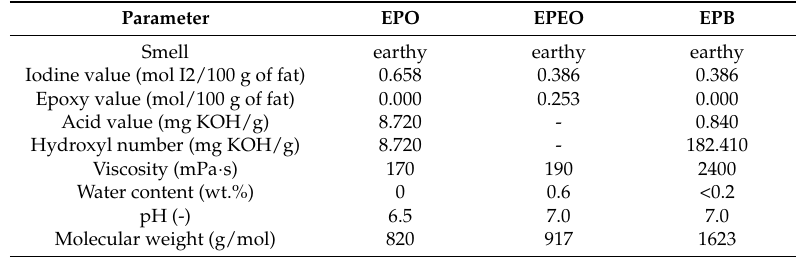
Table 3. Properties comparison of evening primrose oil, epoxidized oil, and biopolyol.